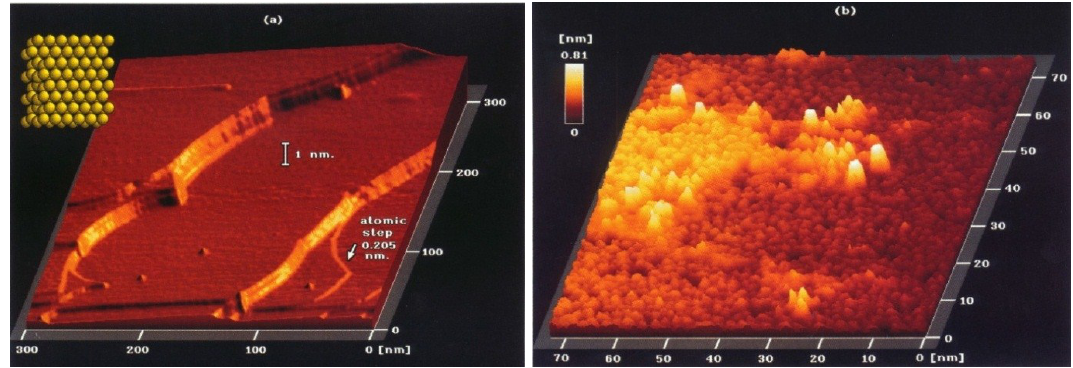
Figure 25. STM images of the Co (0001) surface ( a ) before and ( b ) after 1 h exposure to 4 MPa 2:1 H 2 :CO atmosphere at 523 K. Reproduced from [161]. Copyright 1995, American Chemical